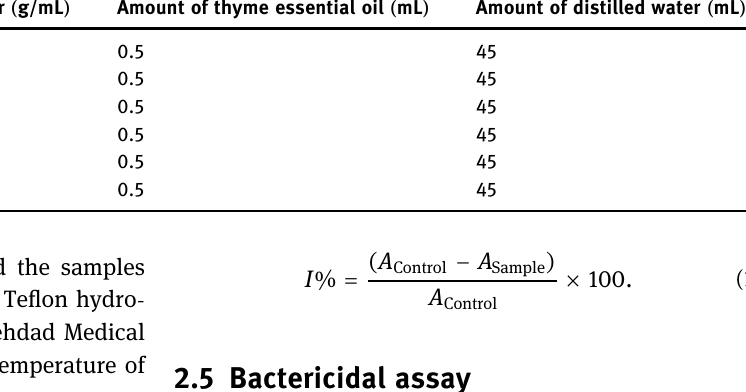
Table 1: Amount of aqueous phase, organic phase, and six di ff erent emulsi fi ers for preparation of thyme essential oil nanoemulsions Type of emulsi fi er Amount of emulsi fi er ( g/mL